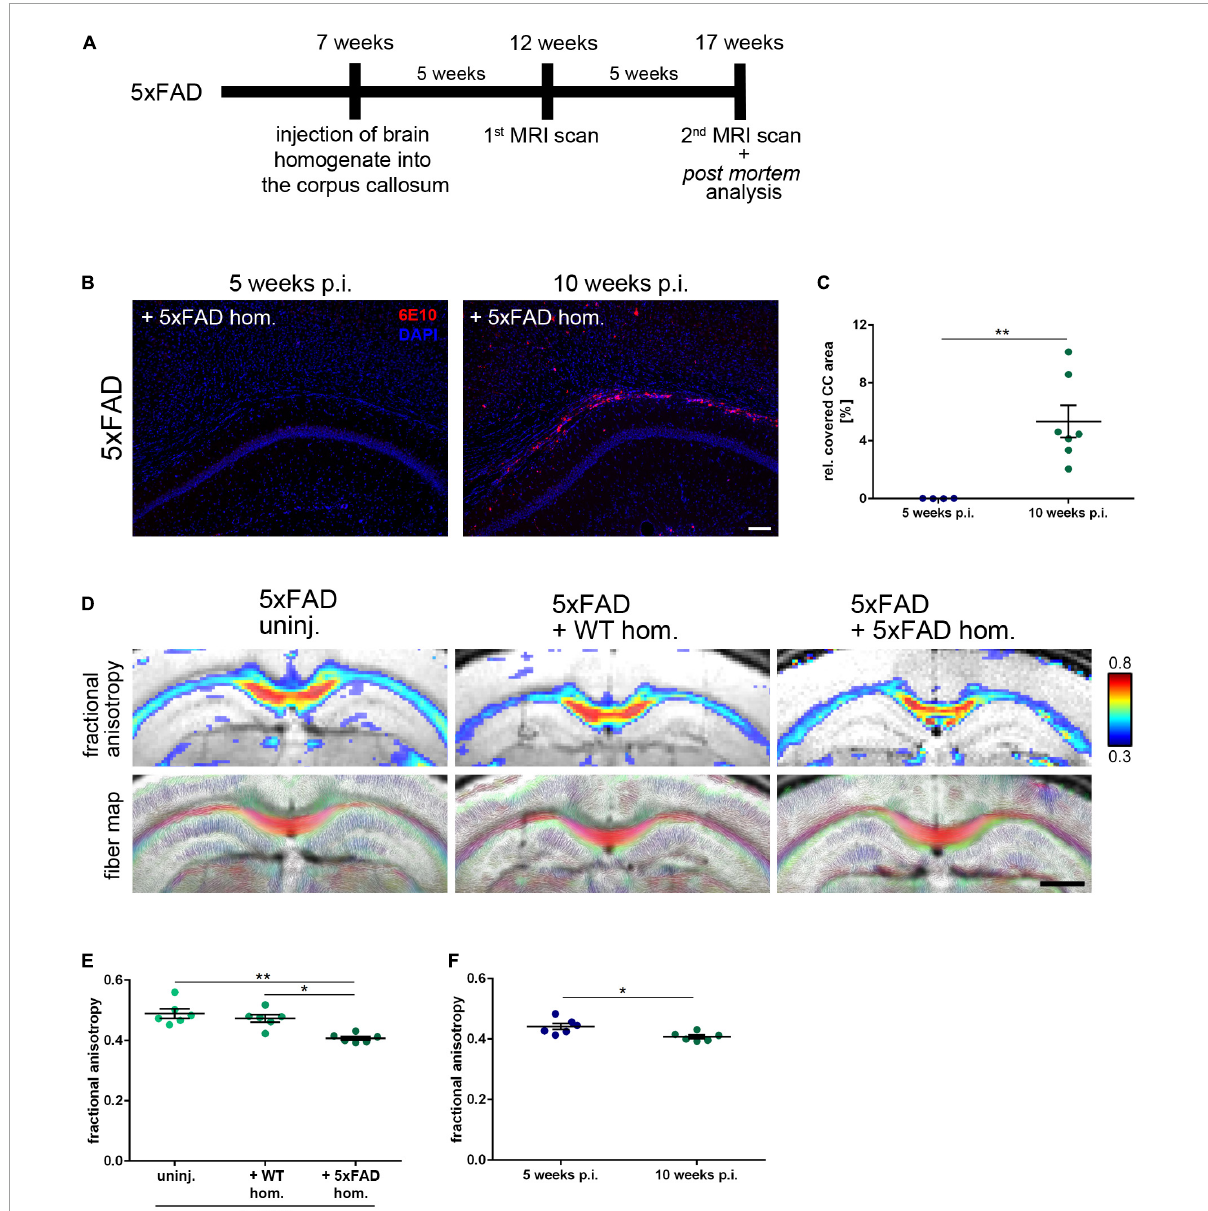
FIGURE5 Seeding-associated demyelination in the corpus callosum (CC). (A) Timeline for the amyloid-beta peptide (A β ) seeding experiments including the performed magnetic resonance imaging (MRI) scans 5 and 10 weeks post-injection (p.i.). (B) Representative fluorescent micrographs of the A β signal (red) of 4-month-old 5xFAD mice 5 and 10 weeks after the intrahippocampal inoculation of A β -containing brain homogenate. Scale bar 100 µ m. (C) Analysis of the A β load relative to the CC. n = 4–7 mice with n = 5 sections analyzed per animal. Each symbol represents data from one animal. Mean ± SEM, unpaired non-parametric t -test (Mann–Whitney), ** p < 0.01. (D) Representative visualization of the fiber density (FD) and high-resolution fiber map of 4-month-old 5xFAD mice 10 weeks p.i. with age-matched WT homogenate or 5xFAD homogenate and an uninjected control. Scale bar 1,000 µ m. (E) Respective analysis of the callosal fractional anisotropy. n = 6 mice. Each symbol represents data from one mouse. Mean ± SEM, Kruskal–Wallis test followed by Dunn’s multiple comparison test, * p < 0.05, ** p < 0.01. (F) Comparison of the fractional anisotropy from seeded 5xFAD mice 5 and 10 weeks p.i. with 5xFAD homogenate. n = 6 mice; Each symbol represents data from one animal. Mean ± SEM, unpaired non-parametric t -test (Mann–Whitney), * p < 0.05.